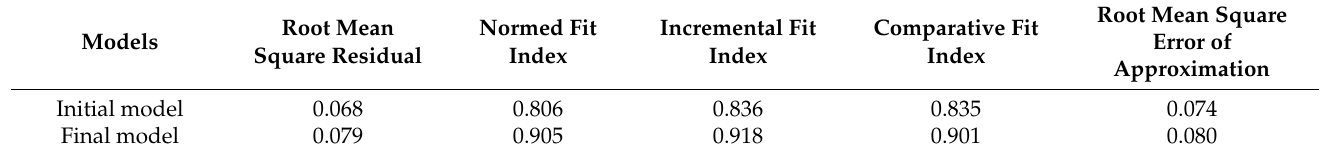
Table 2. Goodness-of-fit in the confirmatory factor analysis.